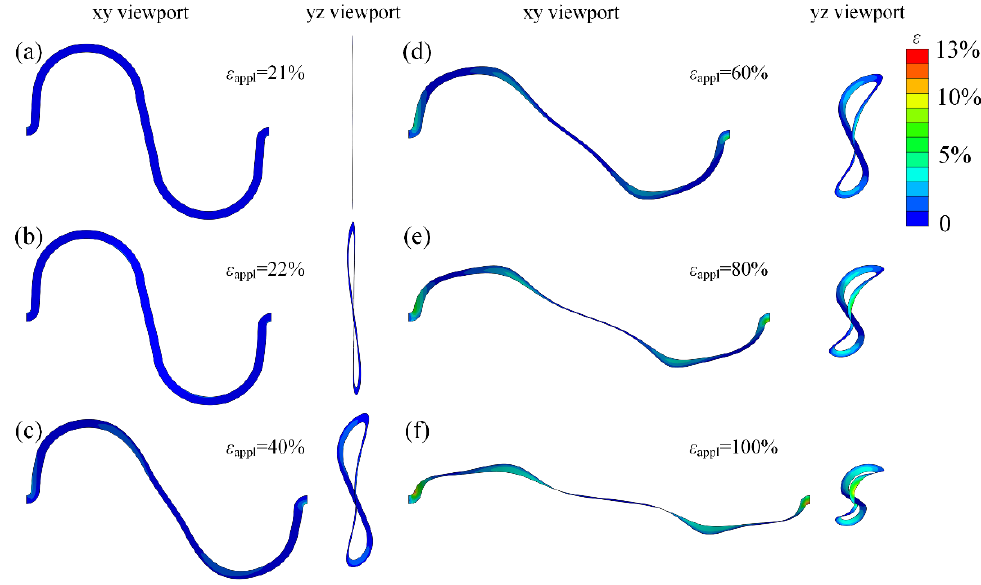
Figure 6. The max principal strain in the bridge versus the applied strain, and the corresponding deformation configurations in xy and yz viewport: ( a ) ε appl = 21%, ( b ) ε appl = 22%, ( c ) ε appl = 40%, ( d ) ε appl = 60%, ( e ) ε appl = 80%, and ( f ) ε appl = 100%.